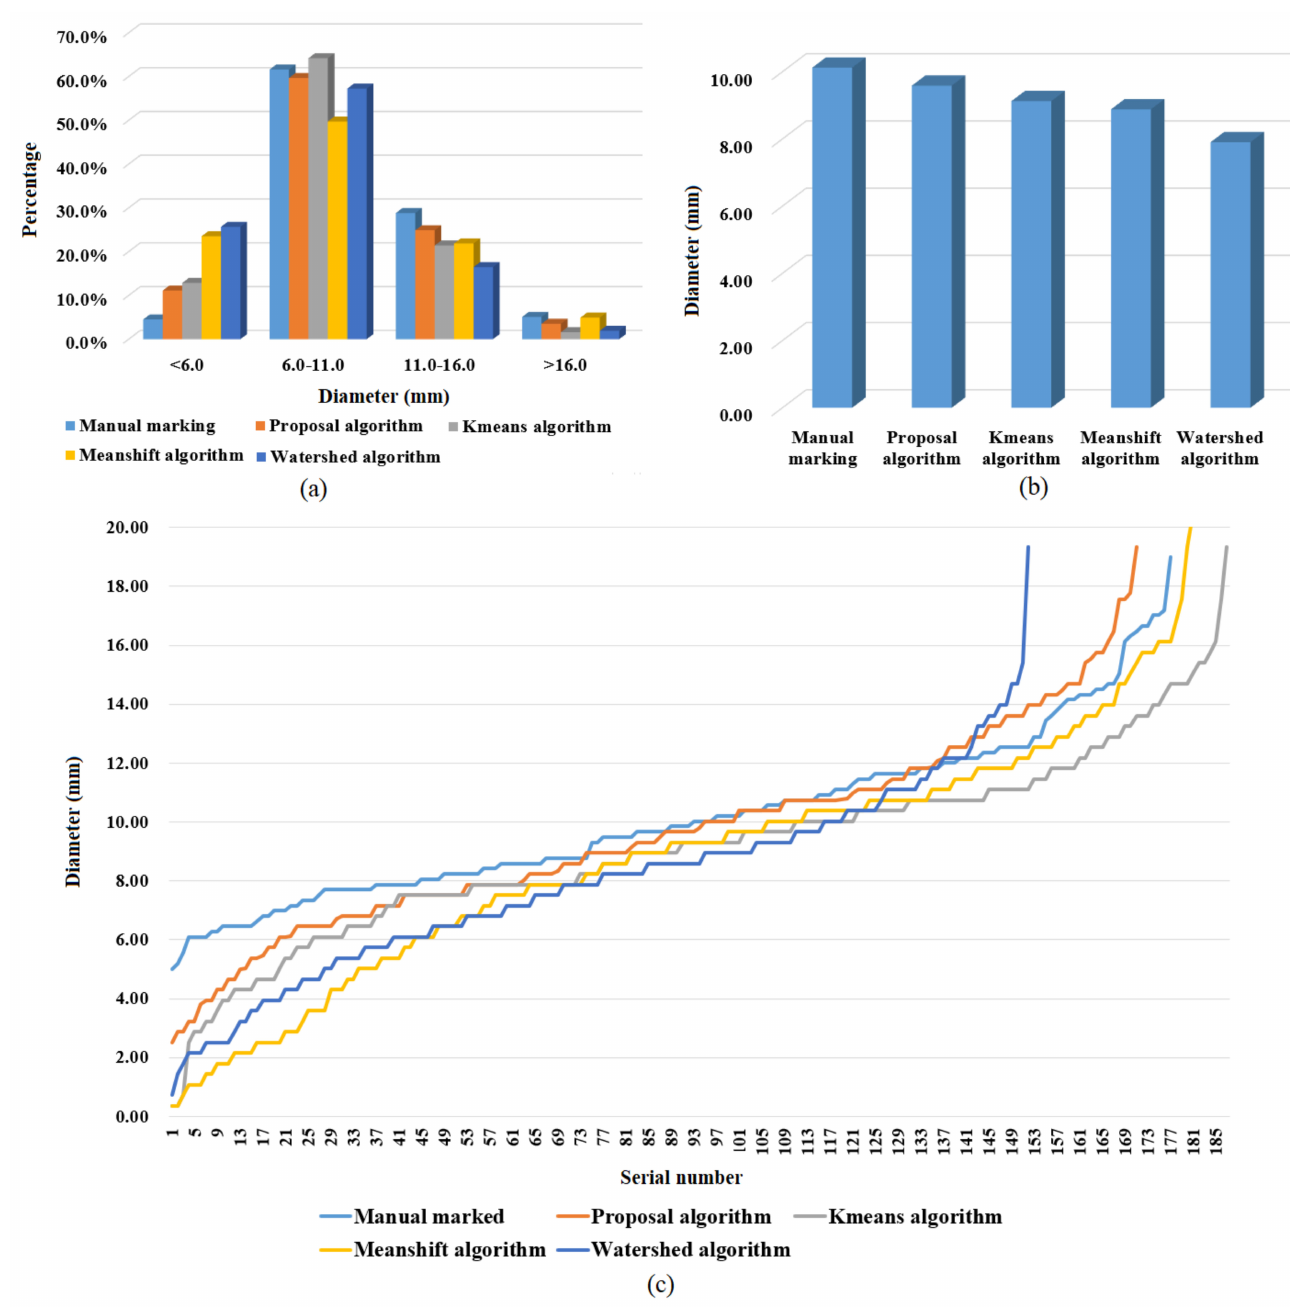
Figure 10. Comparison of the prediction results of the different algorithms and the results of the manual marked method. ( a ) Histogram of pellet size distribution. ( b ) Histogram of average pellet size. ( c ) Line chart of pellet